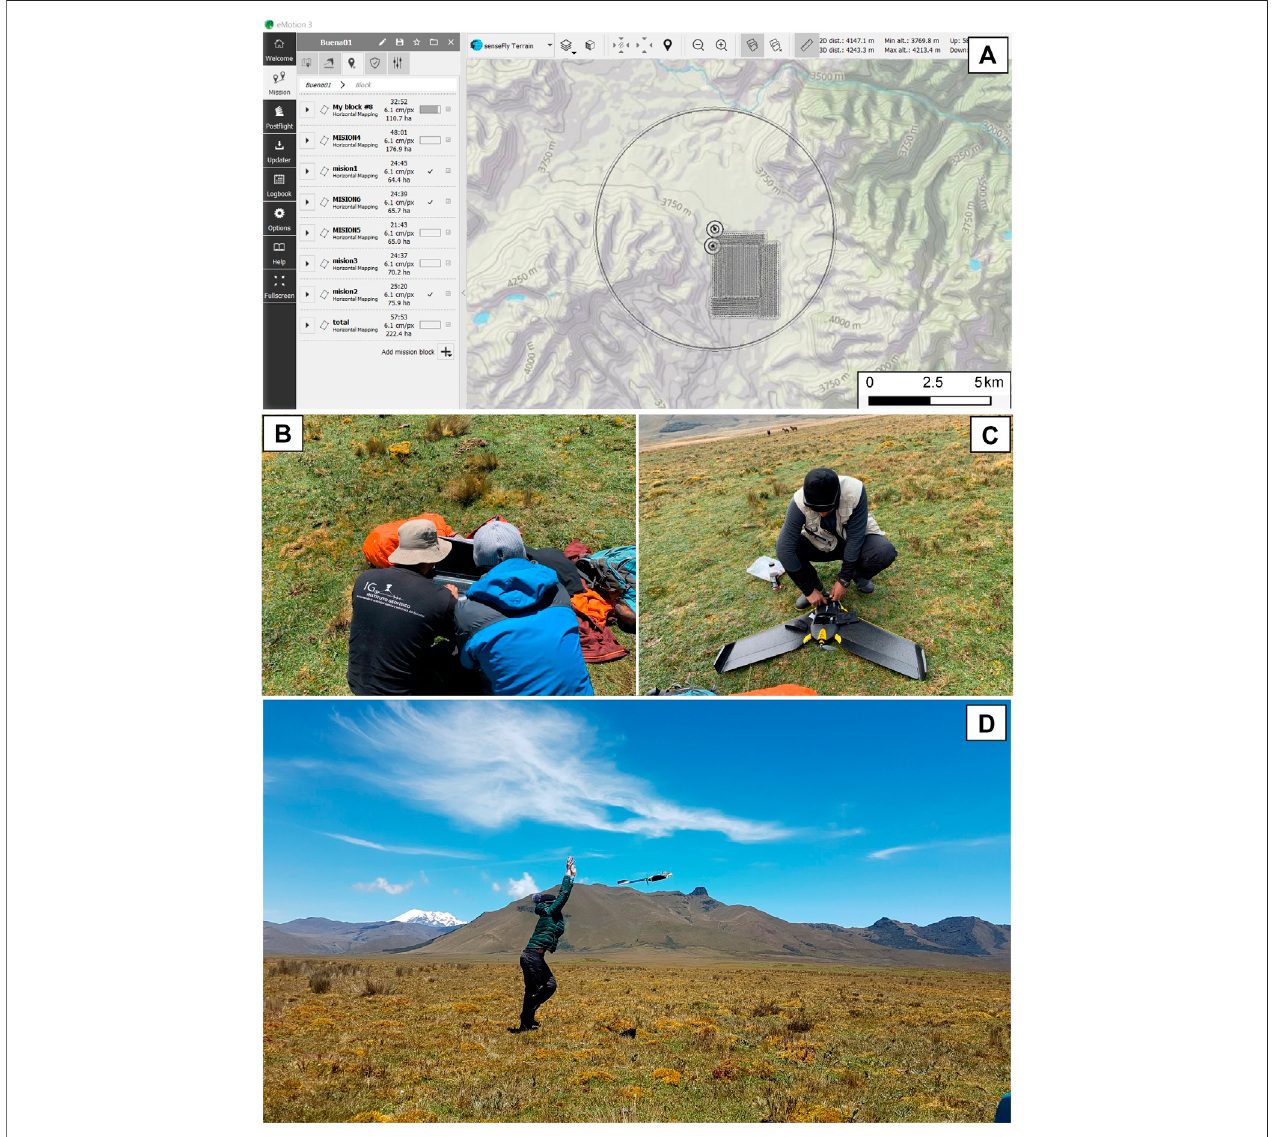
FIGURE 6 | Mosaic of the preparation for the drone survey. (A) Drone survey development on eMotion three software, (B) Ground station and fl ight planning on eMotion software. (C) Change of batteries after landing (D) Launching of the drone.